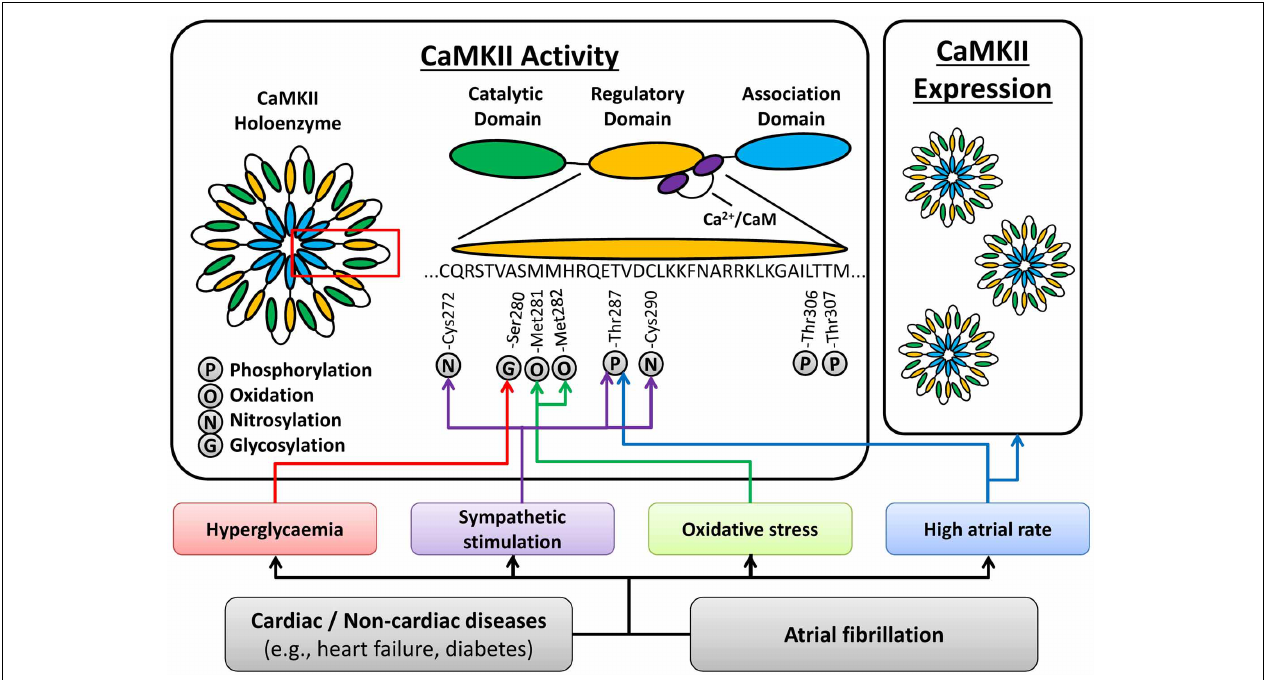
FIGURE 2 | Atrial fibrillation (AF)-related mechanisms promoting CaMKII activation. AF-promoting conditions and/or AF itself can activate CaMKII via high atrial rates, oxidative stress, sympathetic hyperactivity, and hyperglycaemia, resulting in post-translational modifications